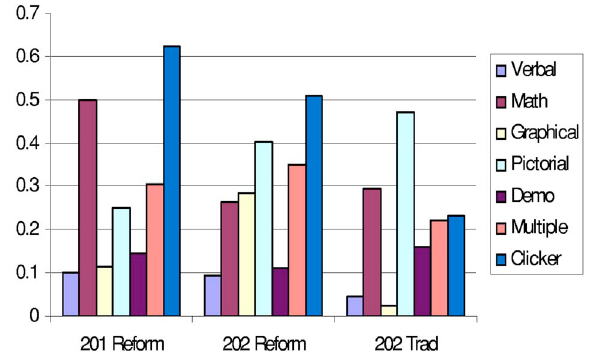
FIG. 4. (cid:1) Color (cid:2) Representational content of the lectures for the reformed 201, reformed 202, and traditional 202 courses. “Mul- tiple” category indicates use of multiple representations. Clicker category indicates fraction of class time involving questions that used a personal response